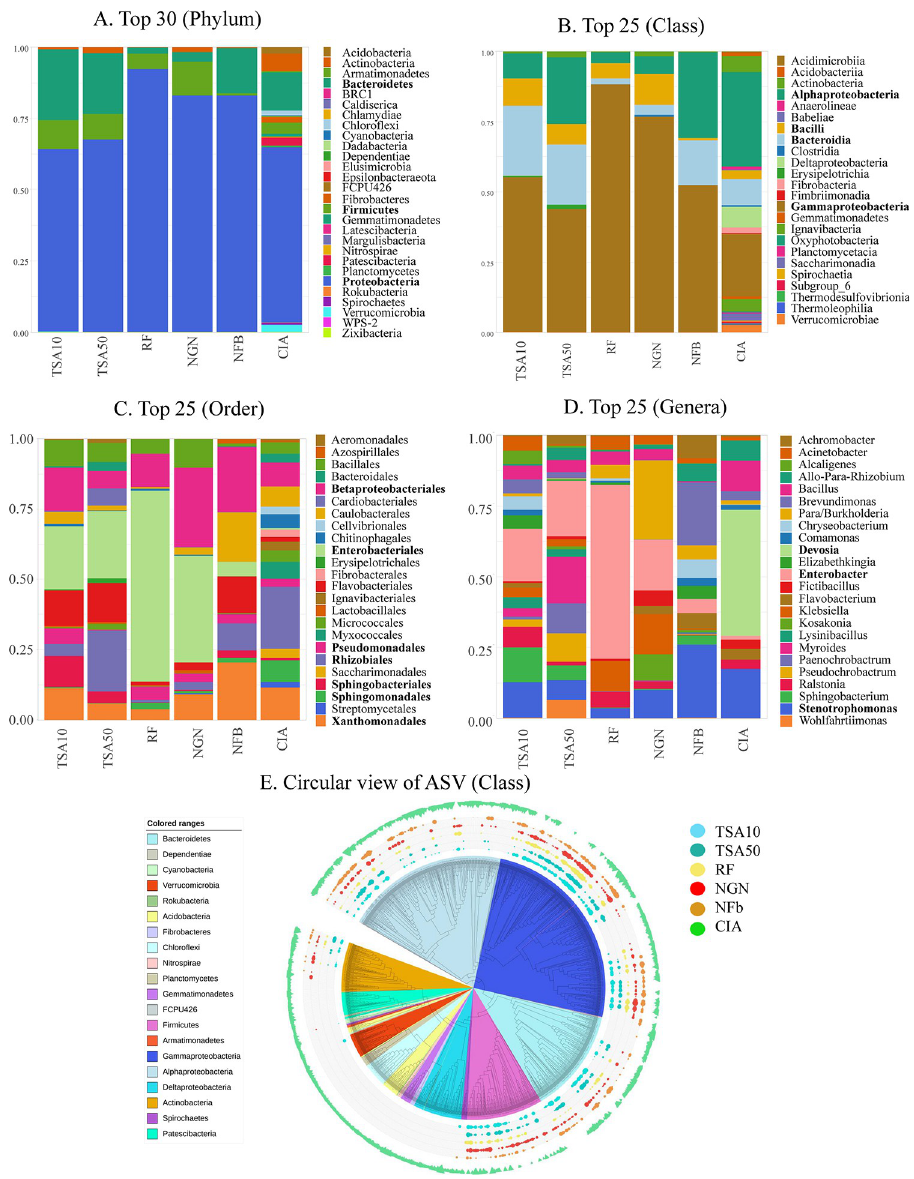
Fig 3. Taxonomic binning of ASV. Taxonomic binning at phylum (A, top 30), class (B, top 25), order (C, top 25) and genus (D, top 25) levels (with most abundant taxa in bold), and a circular phylogenetic tree of ASV with the class-rank distribution among CIA and CDA